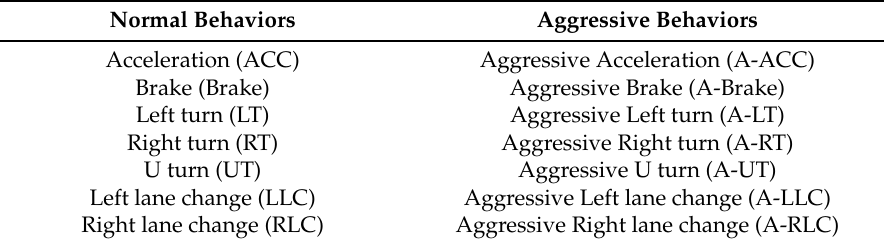
Table 2. The behaviors classified by the proposed